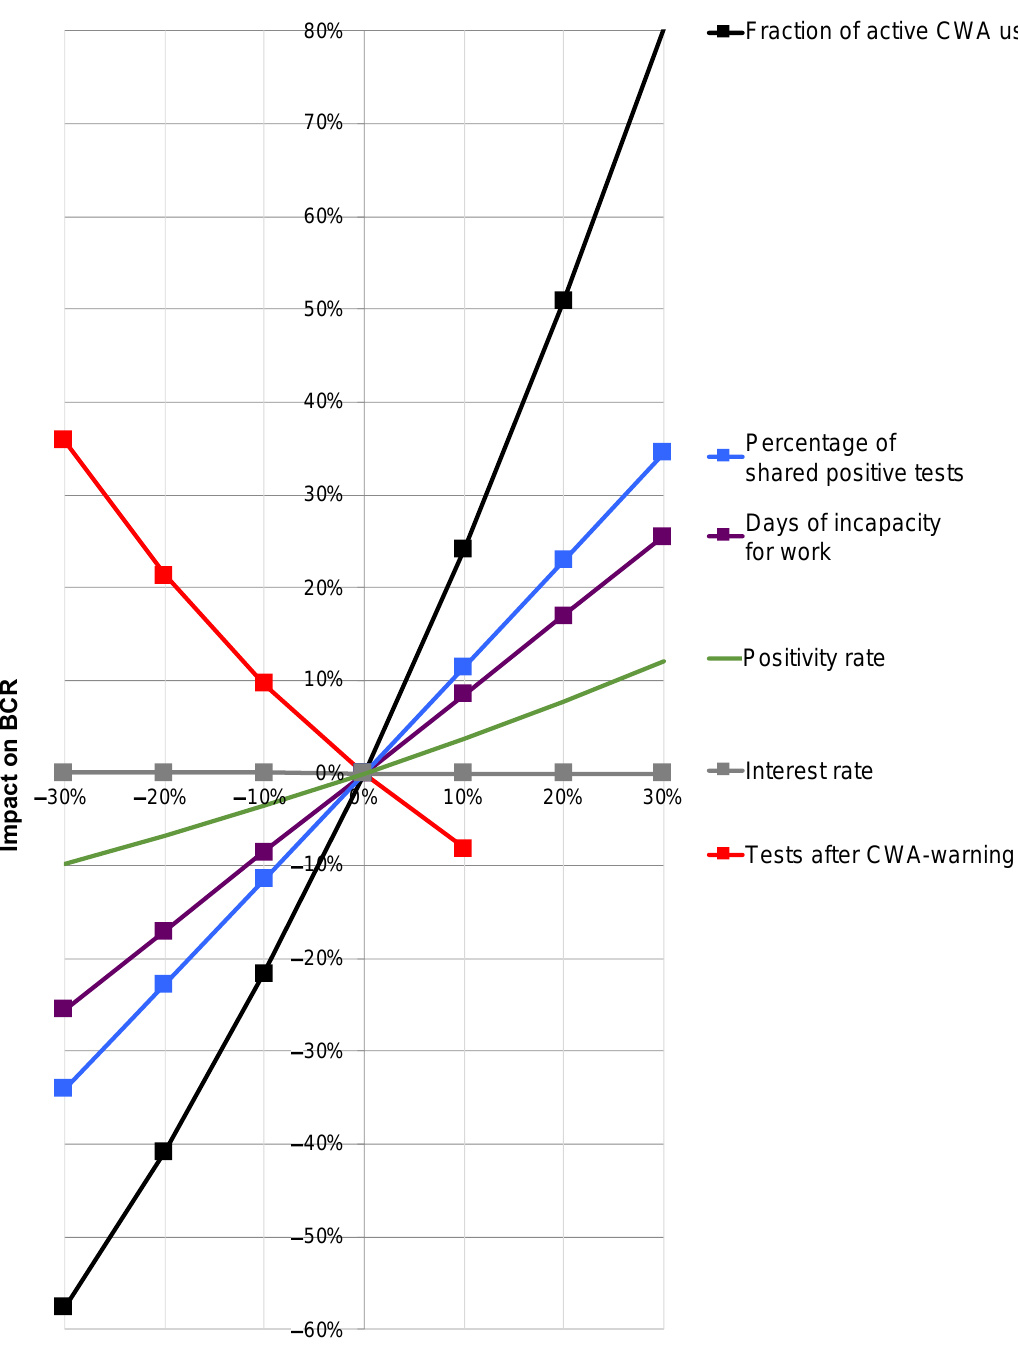
Figure 8. Results of the one-at-a-time sensitivity analysis. Depicted are the percentage variations in the individual base parameters (x-axis) and their percentage impact on the benefit – cost ratio (BCR; y-axis). Red line: rate of perceived testing after red warning by CWA. Purple line: duration of incapacity for work (IfW). Black line: proportion of active users. Blue line: proportion of shared positive test results. Green line: test positivity rate. Gray nearly horizontal line along the x-axis: interest rate.